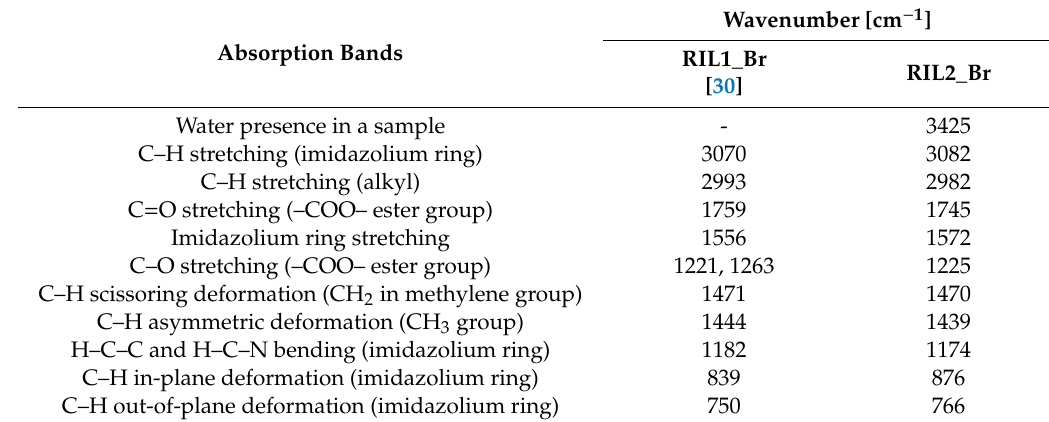
Table 1. Absorption Bands Assignments in RIL1_Br [30] and